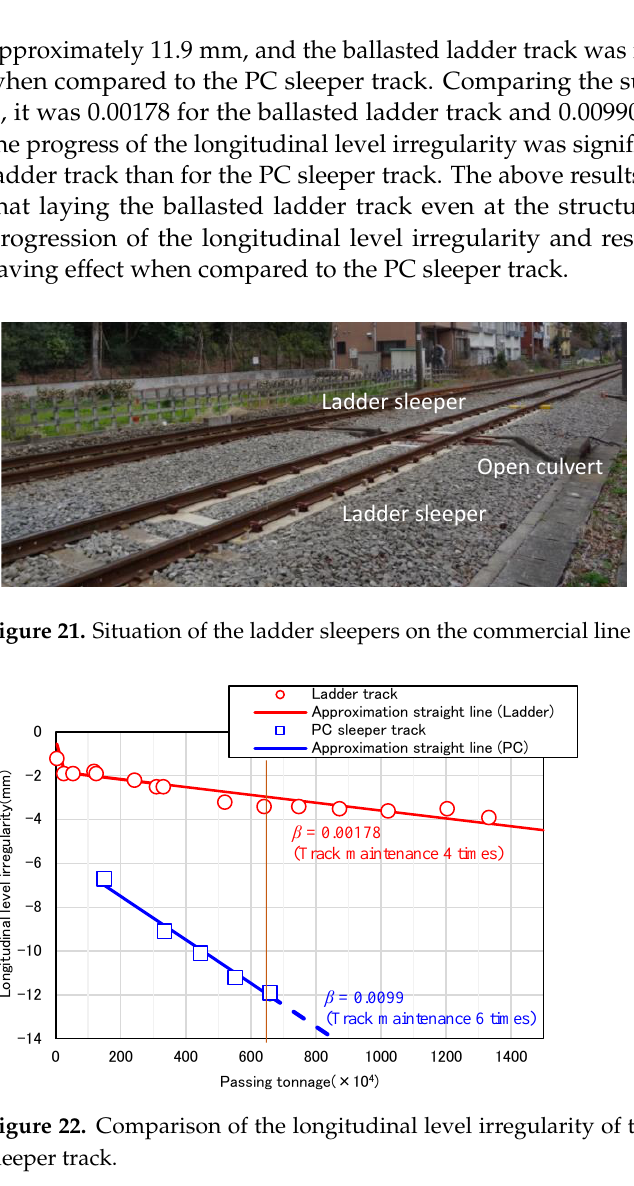
Figure 21. Situation of the ladder sleepers on the commercial line (Support A).